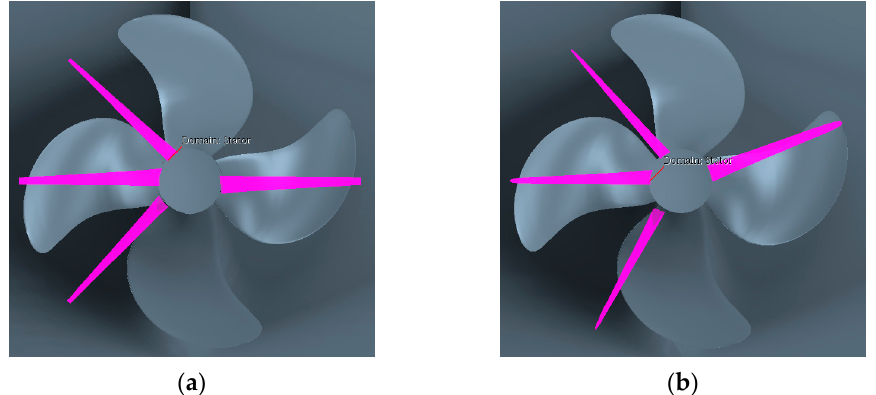
Figure 14. Comparison of profile (looking upstream) ( a ) Previous position (45°, 90°, 135°, 270°); ( b ) Optimized position (40°, 90°, 150°, 290°).